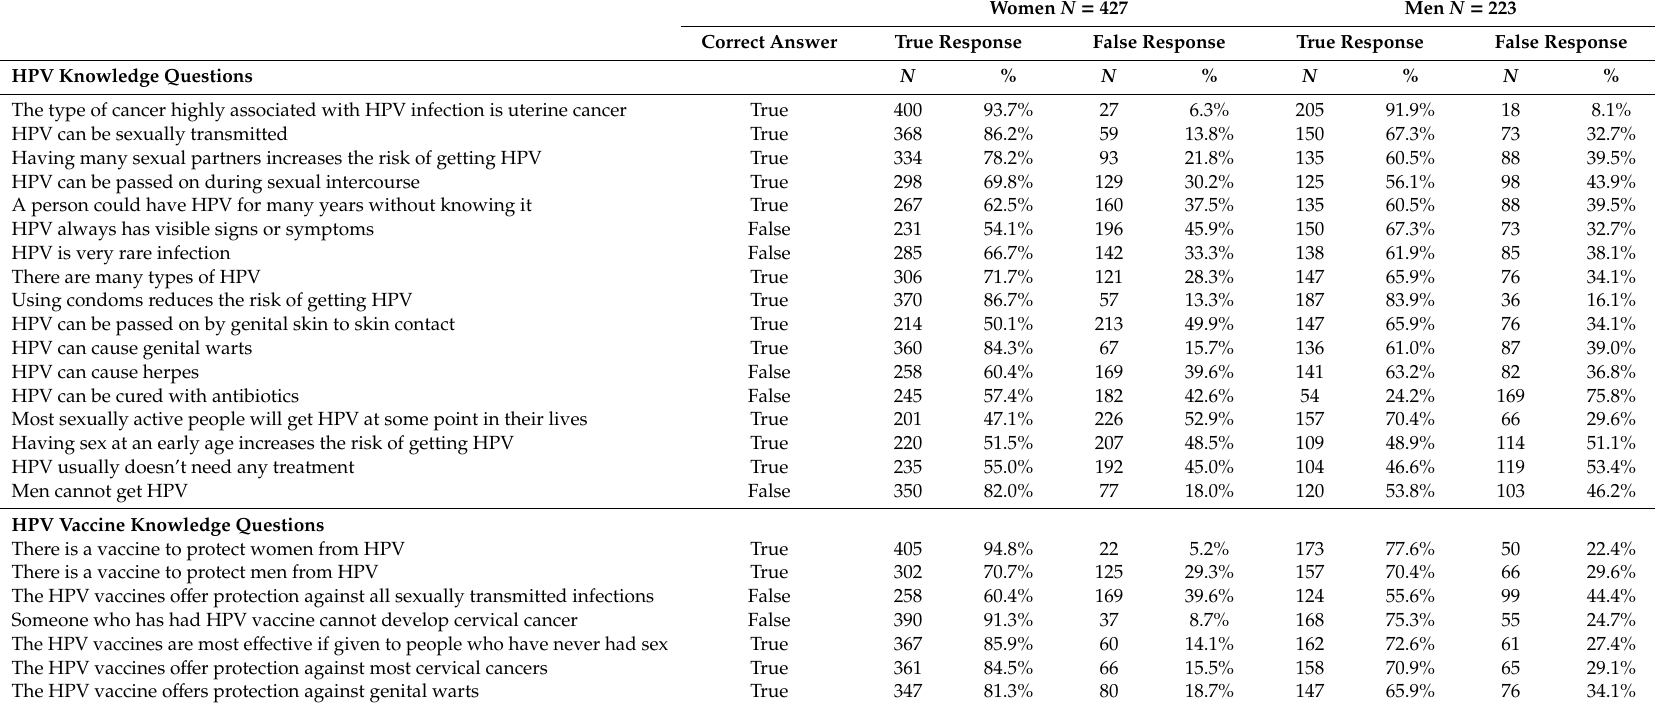
Table 2. Knowledge and beliefs regarding HPV infections and HPV